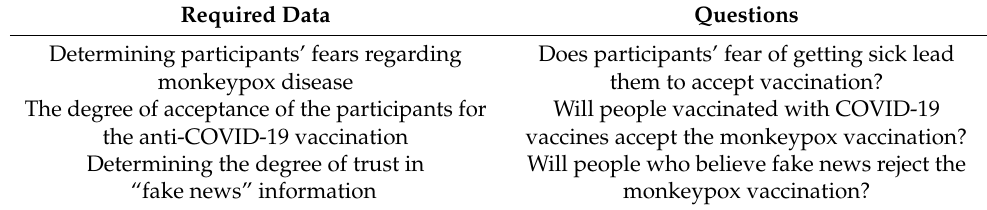
Table 1. Data required and research